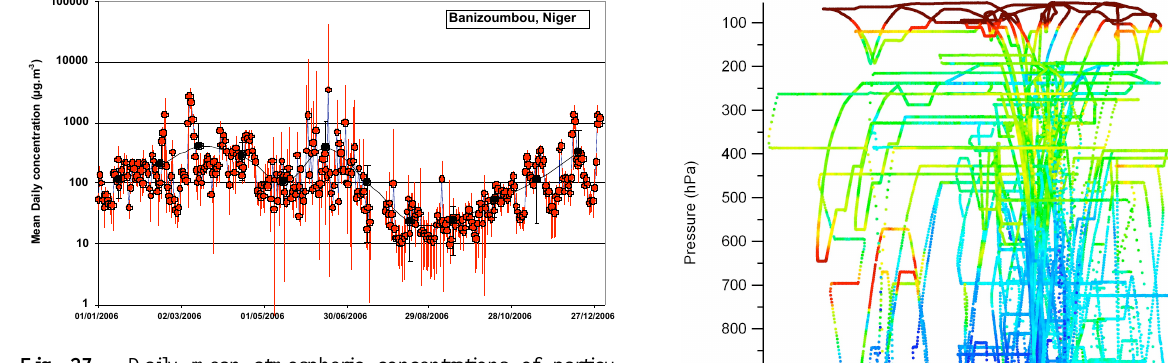
Fig. 27. Daily mean atmospheric concentrations of particu- Figure 27. Daily mean atmospheric concentrations of particulate matter lower than 10 µ m late matter lower than 10 µ m (PM 10 ) (red dots) and daily stan- (PM10) (red dots) and daily standard deviations (red bars) measured in Banizoumbou (Niger, 13.31°N/2.66°E; see its location on Fig.1) in 2006. The black dots represent the monthly dard deviations (red bars) measured in Banizoumbou (Niger, means and standard deviations. (Note that the daily mean concentrations have been computed 13.31 ◦ N/2.66 ◦ E; see its location on Fig. 1) in 2006. The black dots based on a selection of raw data using wind direction criterions to select only dust transport represent the monthly means and standard deviations (note that the wind sectors). daily mean concentrations have been computed based on a selec- Figure 28. Flight tracks for the BAe-146, the DLR Falcon, the French Falcon and the M55 Fig. 28. Flight tracks for the BAe-146, the DLR Falcon, the French tion of raw data using wind direction criterions to select only dust between 20 th July and 21 st August plotted as a function of latitude and altitude and coloured Falcon and the M55 between 20 July and 21 August plotted as a transport wind sectors). by the 0 3 concentration. Note that the ozone concentrations above 100 hPa are off the colour function of latitude and altitude and coloured by the ozone concen- scale, extending up to 1700 ppb. tration. Note that the ozone concentrations above 100hPa are off the colour scale, extending up to